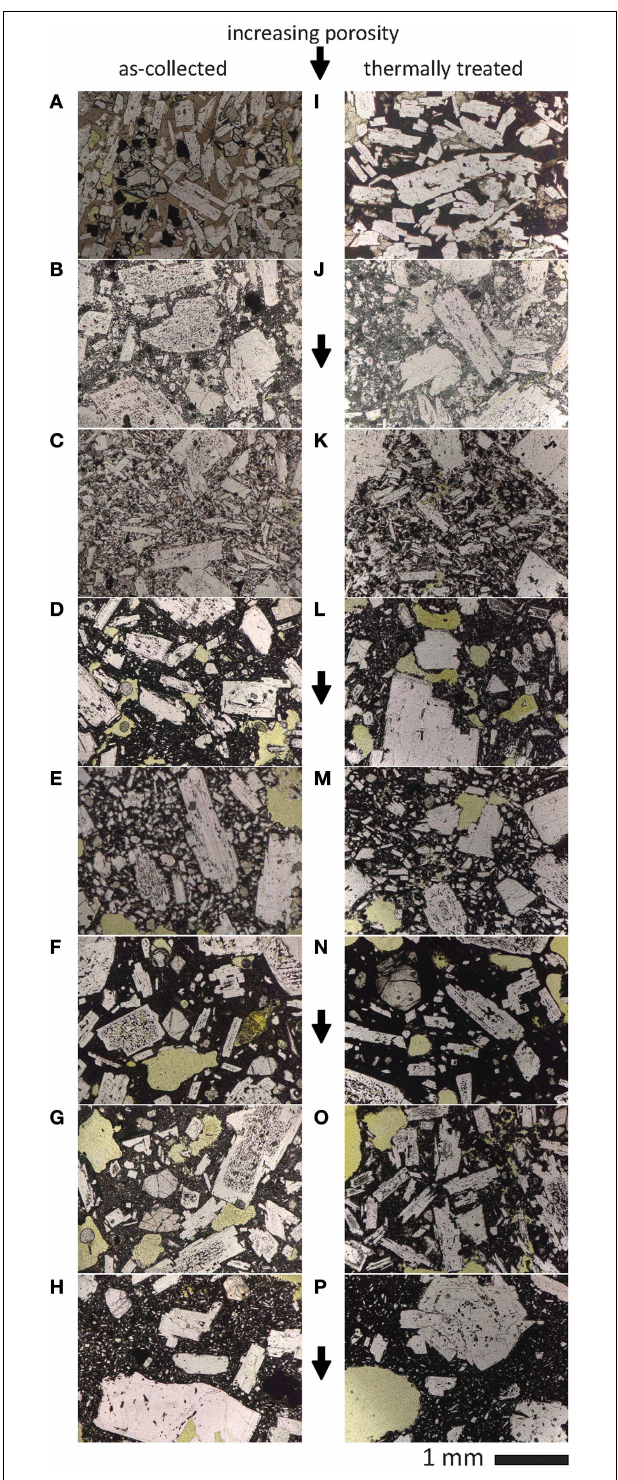
FIGURE 2 | Photomicrographs of the samples chosen for this study (Left, As-collected samples; Right, Thermally stressed samples). (A) PAC_2013_1 shows intact phenocrysts and few microlites set in a glassy groundmass; (B) PAC_RF_2 is made of large plagioclase phenocrysts